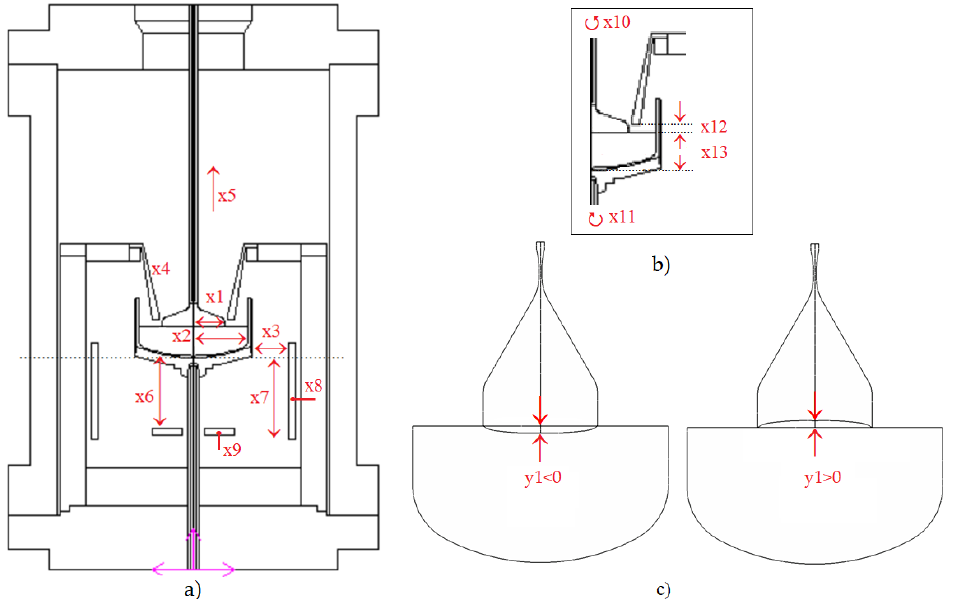
Figure 1. Furnace for Cz-Ge growth: ( a , b ) geometry with a definition of the main geometric and process parameters: x 1 , crystal radius; x 2 , crucible radius; x 3 , distance between crucible and side heater; x 4 , shield emissivity; x 5 , pulling rate; x 6 , distance between crucible and bottom heater; x 7 , axial displacement of side heater; x 8 , power of side heater; x 9 , power of bottom heater; x 10 , crystal rotational rate; x 11 , crucible rotational rate; x 12 , distance from the radiation shield to the melt; x 13 , melt height; ( c ) definition and a sign of interface deflection y 1 .